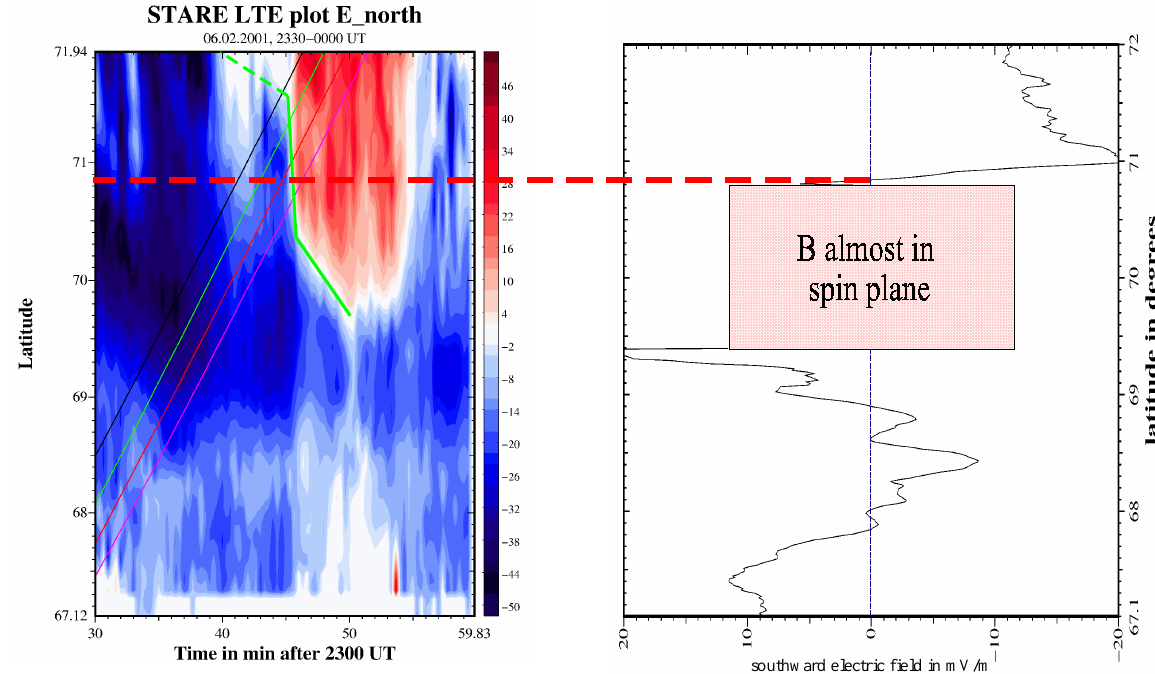
Fig. 4. Left panel: STARE northward electric field component data (in mV/m), along the central meridian of the radar’s field of view for each time step. Cluster II magnetic footprints as in Fig. 3. Thicker green line: location of the convection reversal boundary (CRB; dashed: approximate location). Right panel: southward component of the electric field measured by the EFW instrument on Cluster II spacecraft 2 (in mV/m). Dashed red line: CRB as inferred from the EFW data.